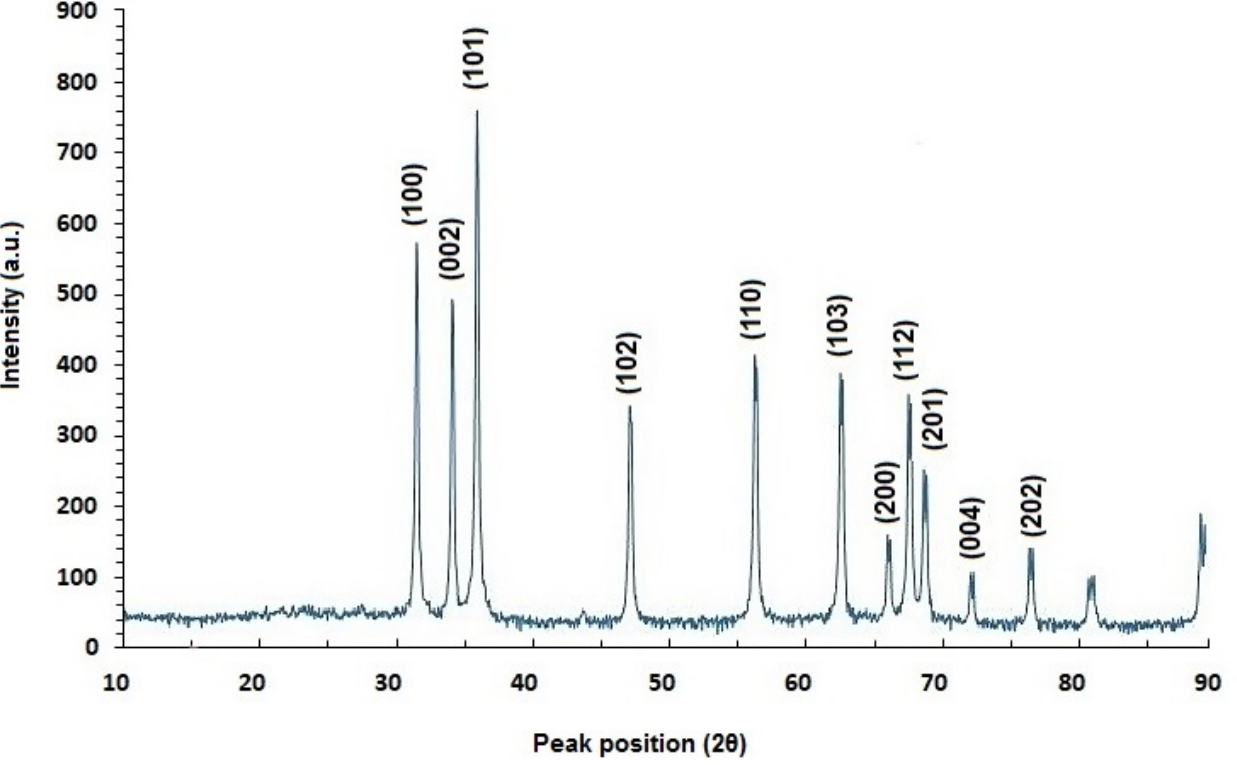
Figure 2. XRD patterns of green-synthesized ZnO NPs using phlomis leaf extract. (Reference code: 96-900-4179